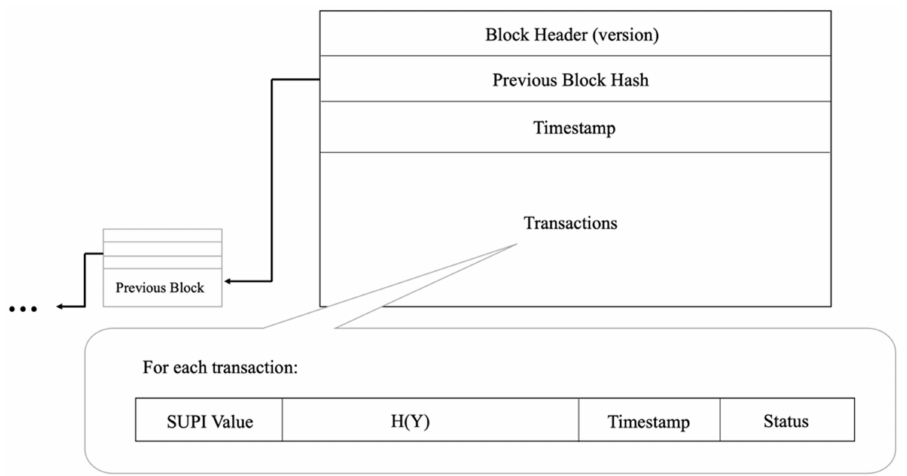
Figure 3. Structure of a block and a